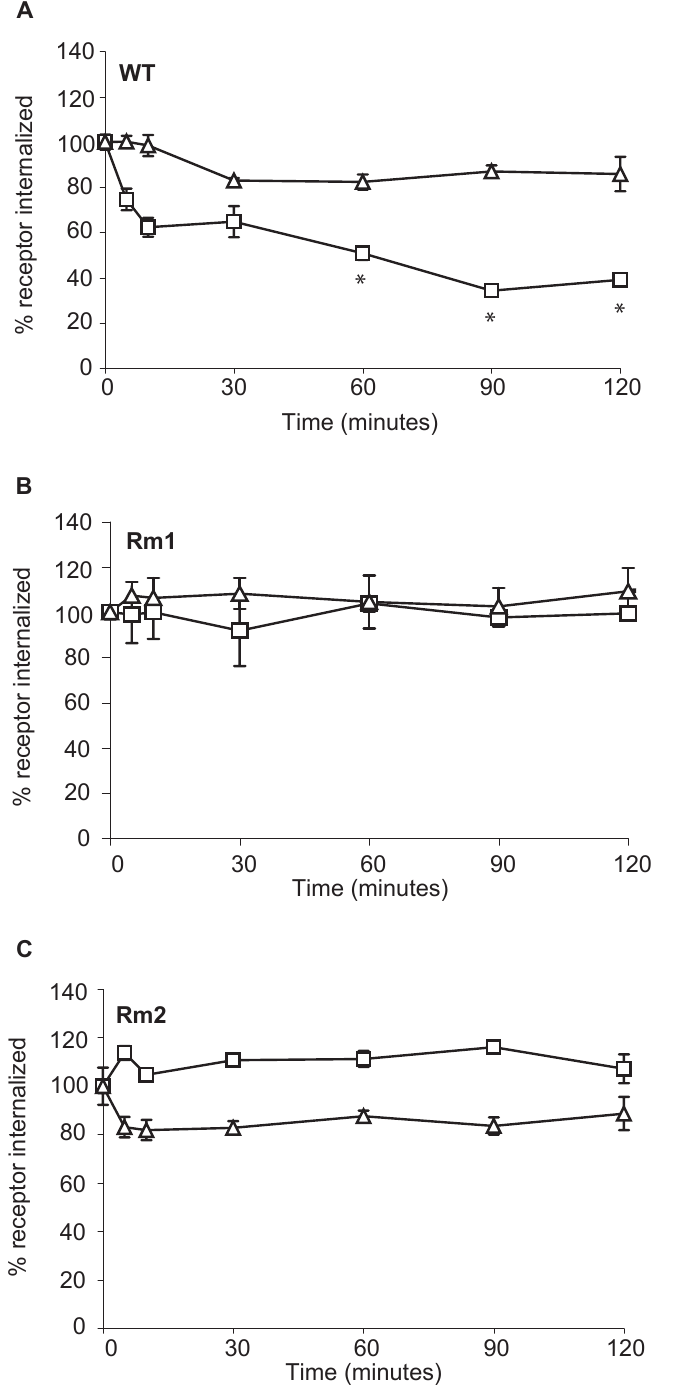
Figure 7. HEK293 cells stably expressing wild-type MC4R (A), Rm1 (B), and Rm2 (C) were exposed to 1 m M a -MSH or THIQ for the times indicated. Cell-surface FLAG-tagged receptors were measured by ELISA. Receptor internalization was calculated as the loss of receptor expression from the cell surface. After 60 min, significantly more wild-type MC4R was internalized ( p , 0.05) in response to a -MSH than THIQ. Data represent the mean 6 s.e.m. of two independent experiments, each performed in